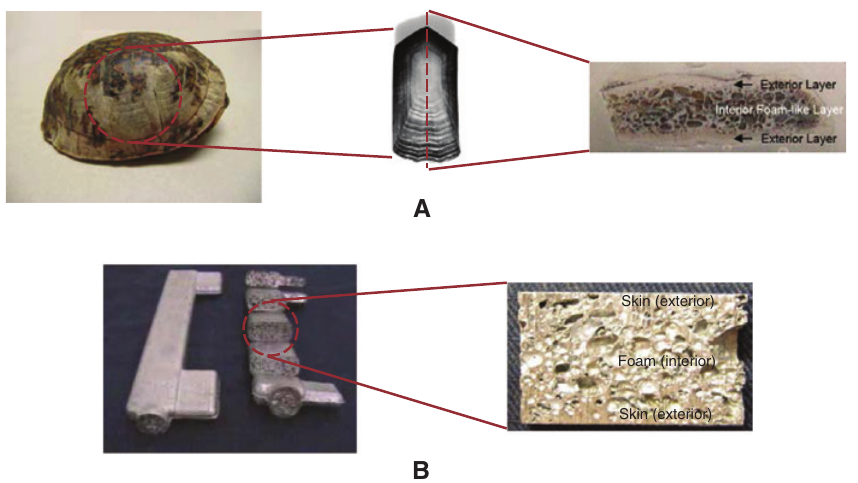
Figure 1 Comparison of hierarchical structures between (A) biological structural material (turtle shell) and (B) synthetic counterpart material (metallic